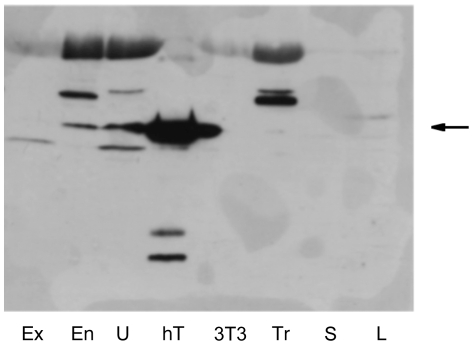
Western blots of human tissues and cultured cell lines using a commercial mouse polyclonal antibody.The antibody was raised against human recombinant 25-kDa hThTPase. The samples were homogenized and centrifuged (20 000× g, 30 min). In the case of the biological samples, 40 µg of cytosolic protein were loaded on the gel; for hThTPase, the amount was 0.5 µg. The arrow indicates the location of 25-kDa hThTPase. (Ex, ectocervix; En, endometrium; hT, human recombinant ThTPase; L, human LN-18 glioblastoma cells; S, human SK-N-BE neuroblastoma cells; U, uterus; Tr, trophoblast).